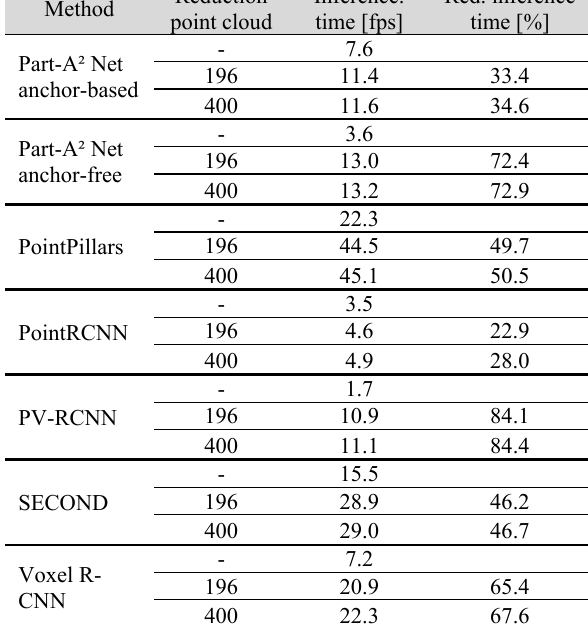
Table 4 . Inference time on original (-) and thinned point clouds (reduction factors 196 & 400).